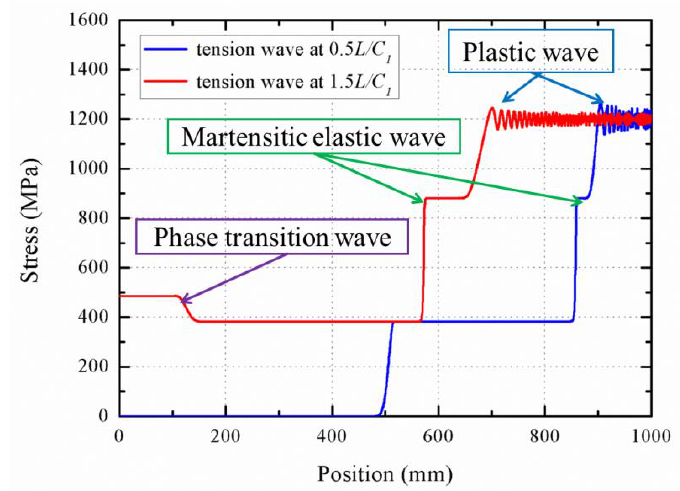
Figure 13. Stress profiles during the propagation and reflection of stress wave under high stress level.